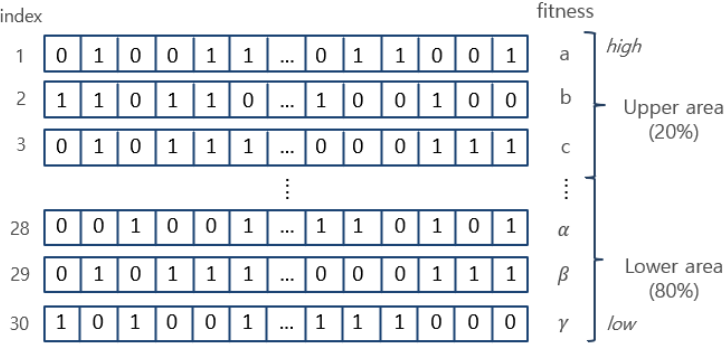
Figure 2. Divided harmony memory.